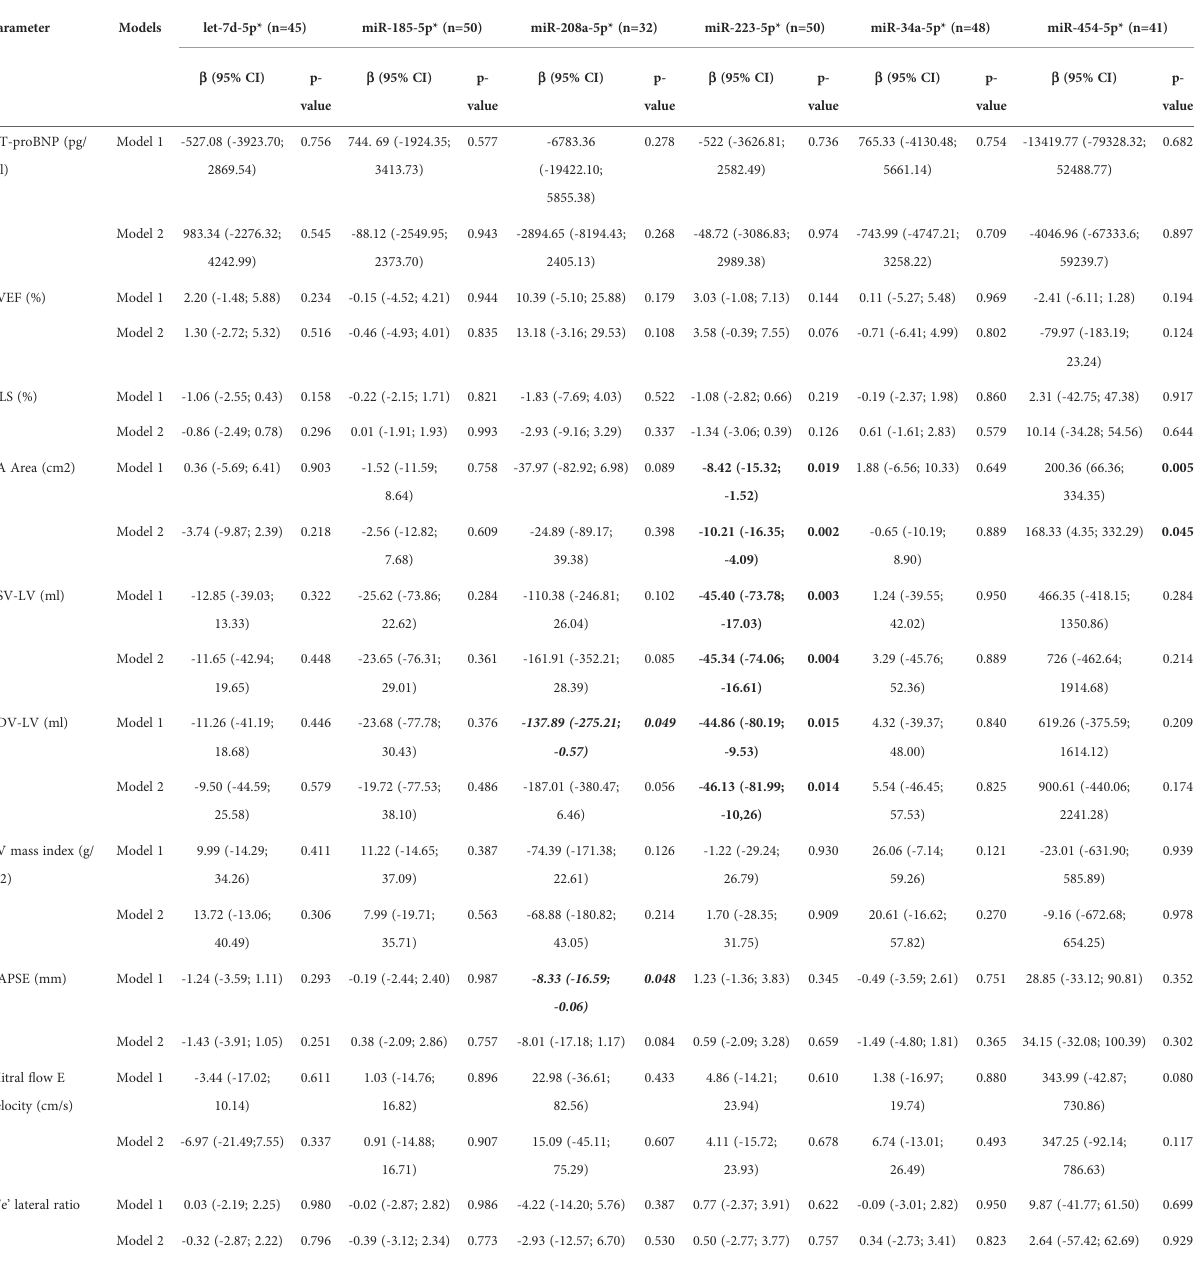
TABLE 1 The association between miRNAs levels and markers of myocardial injury in patients with Chronic Chagas Cardiomyopathy (n=74).